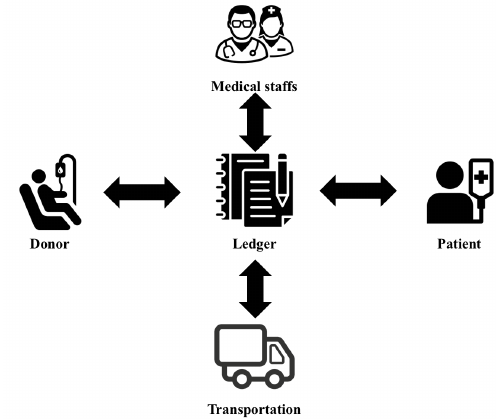
Figure 2. The overall architecture of the BloodChain model.